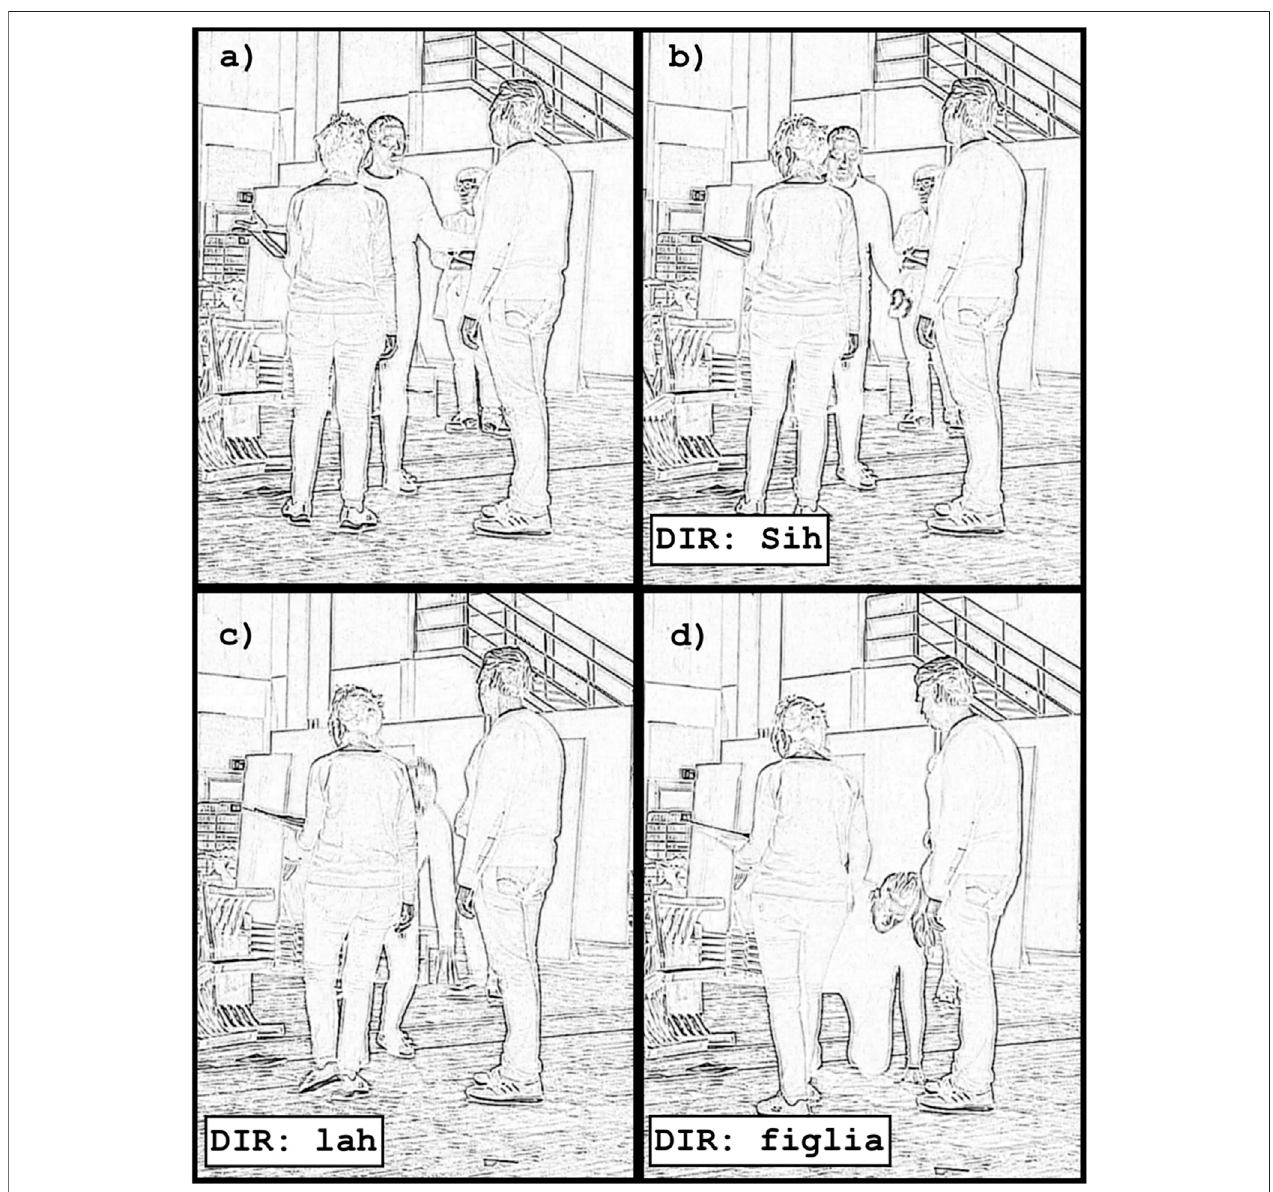
FIGURE 6 | The director progressively kneels down, demonstrating the effort it would take for the baritone ’ s character to do so.